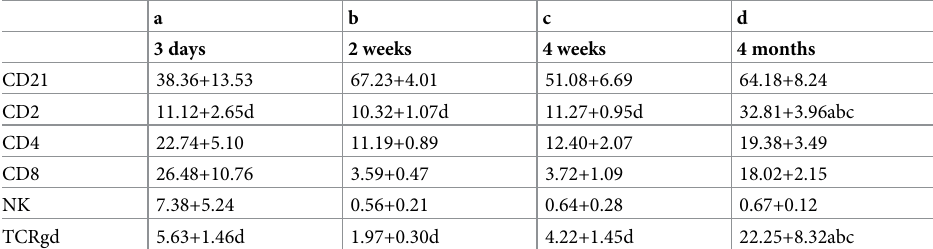
Table 7. Percentages of the studied populations of lymphocytes in the ileum. a